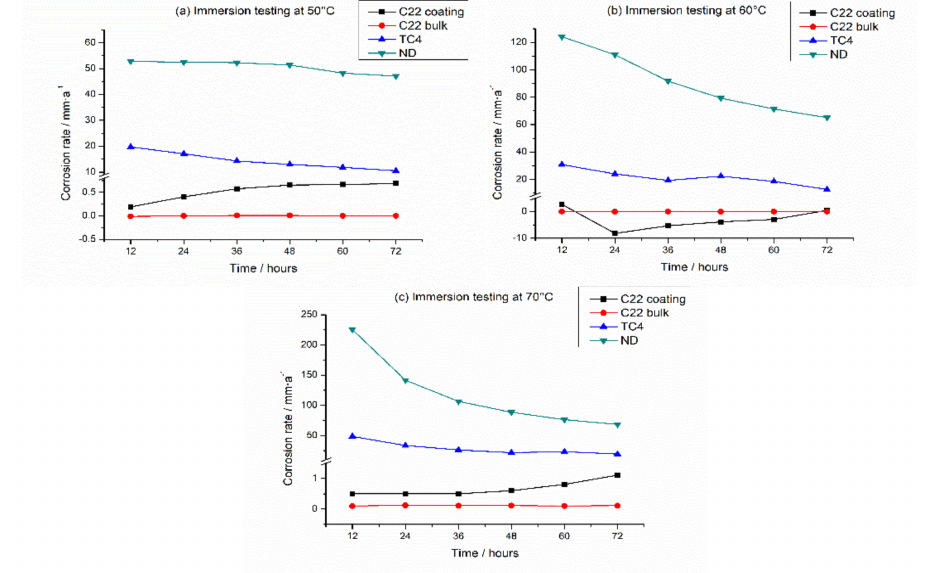
Figure 6. Corrosion rate (R) versus time curve of the C22 coating, C22 bulk, TC4, and ND in 50 wt.% H 2 SO 4 immersion testing at ( a ) 50 ◦ C, ( b ) 60 ◦ C, and ( c ) 70 ◦